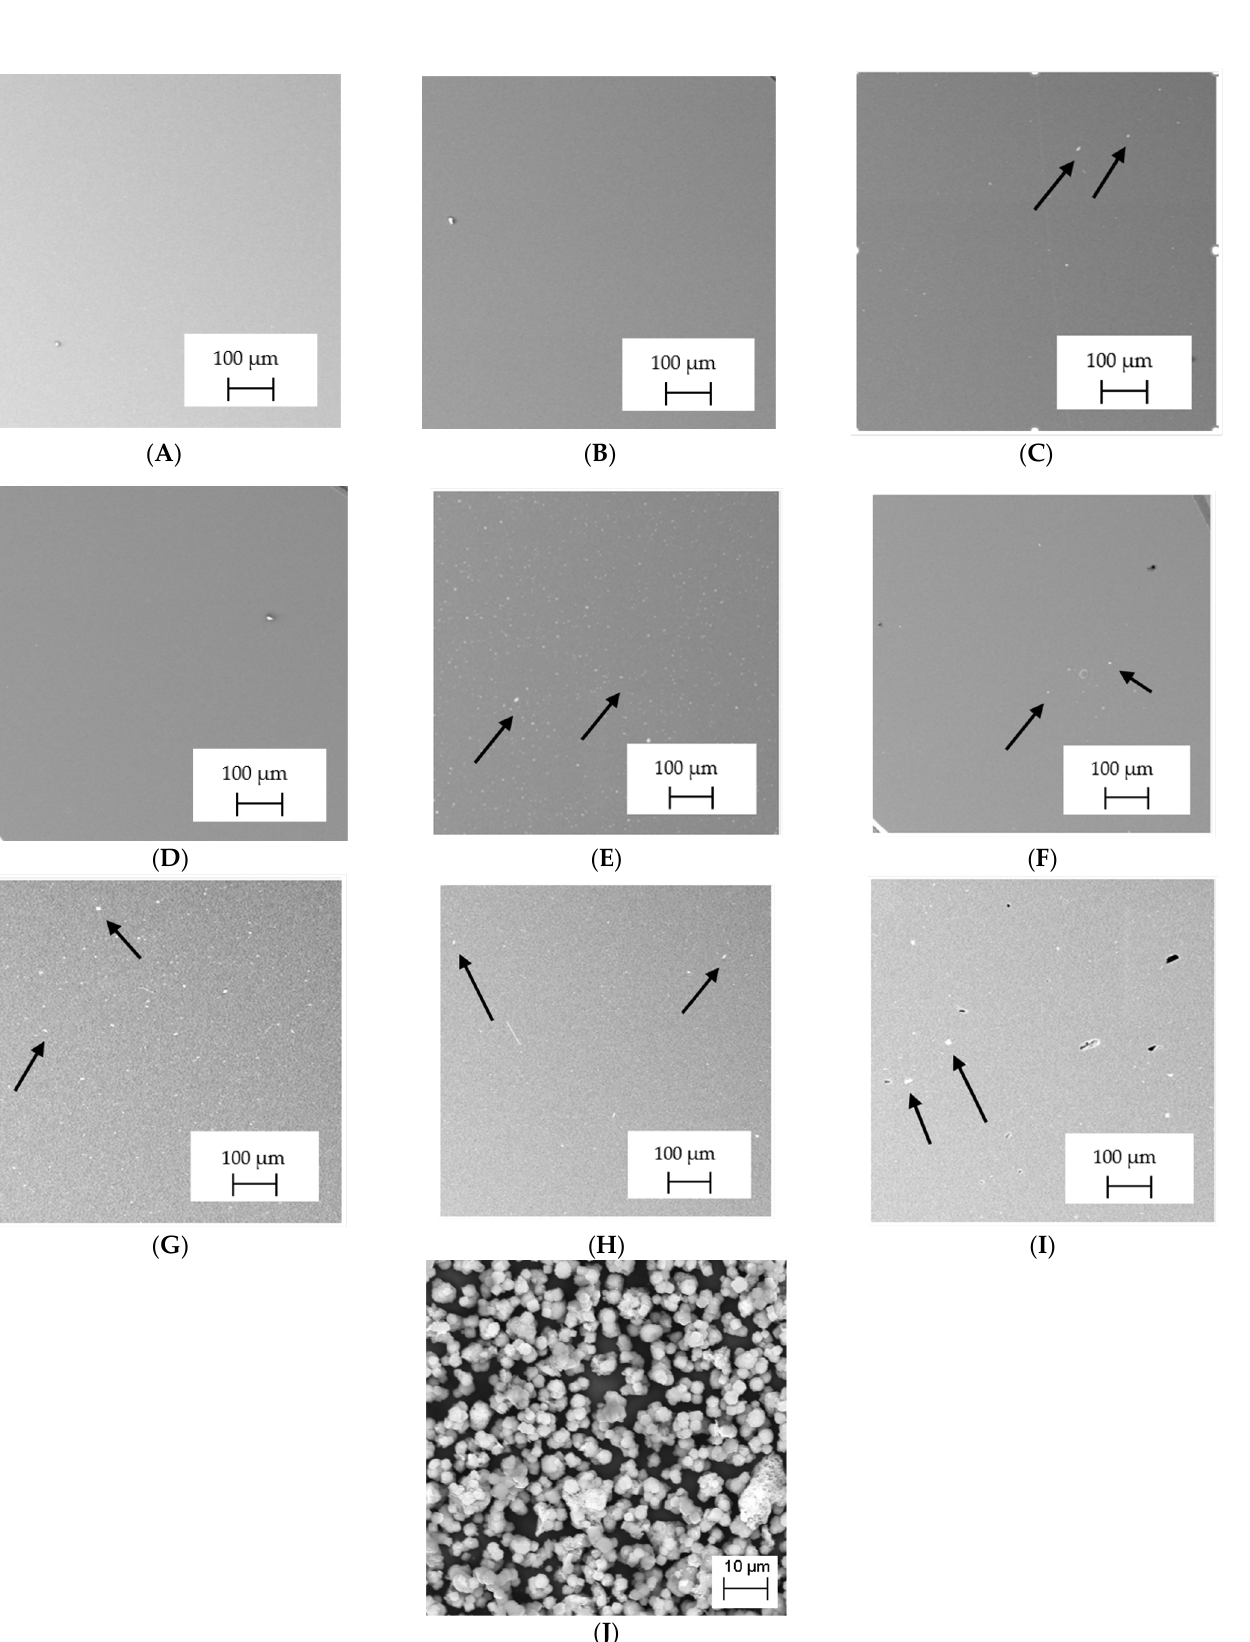
Figure 1. Results of SEM–BSE cross-area observations. Black arrows indicate exemplary particles of additives. ( A – I ): specific type of material analyzed. ( J )—additive used in material E.